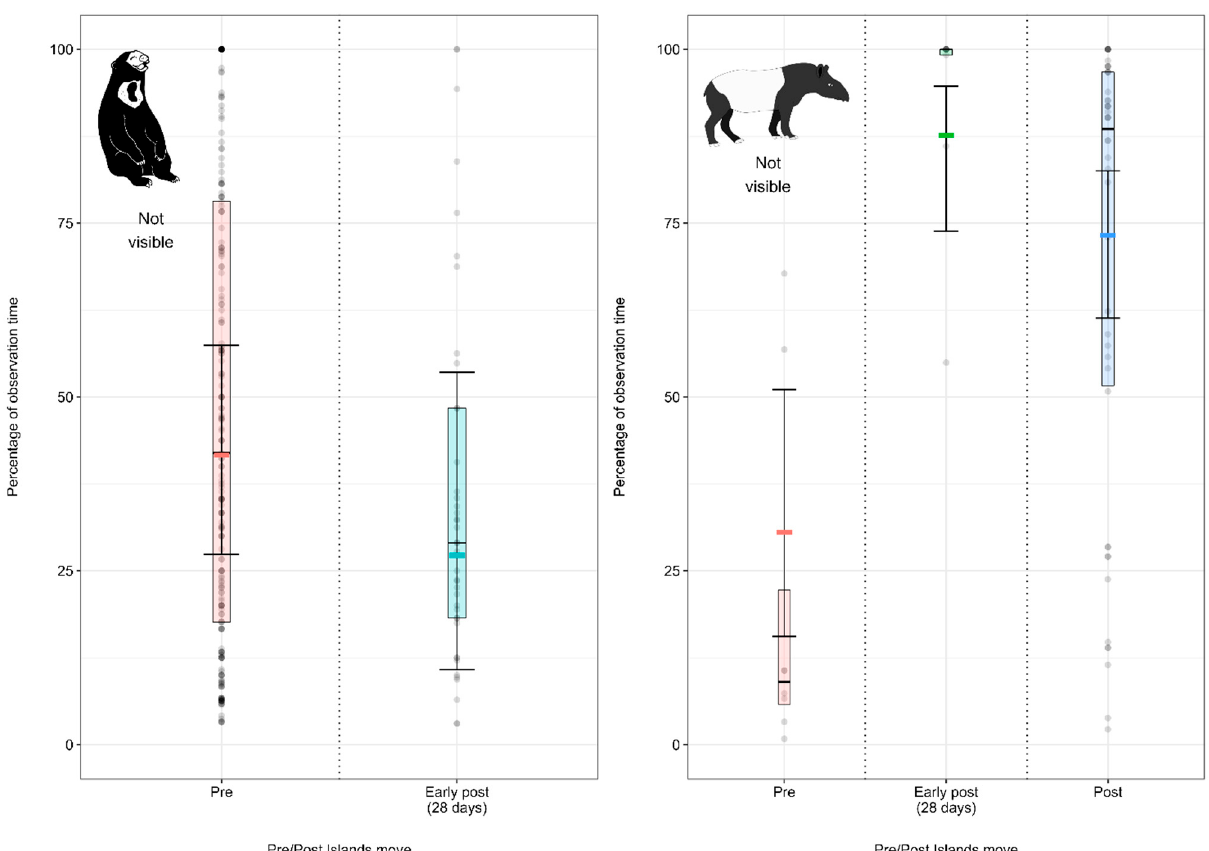
Figure 7. Proportion of observation time (expressed as a percentage of the total observation time) Malayan sun bears and Malayan tapirs spent out of sight of observers/public under the pre-, early- post- and post-enclosure-move conditions. The model’s fitted values are represented by coloured horizontal lines, and their respective 95% confidence intervals are depicted as black error bars. Coloured boxes with black horizontal lines depict the medians and quartiles of the response. Grey dots represent raw data points, shaded according to frequency (dark indicates many observations, light indicates few).